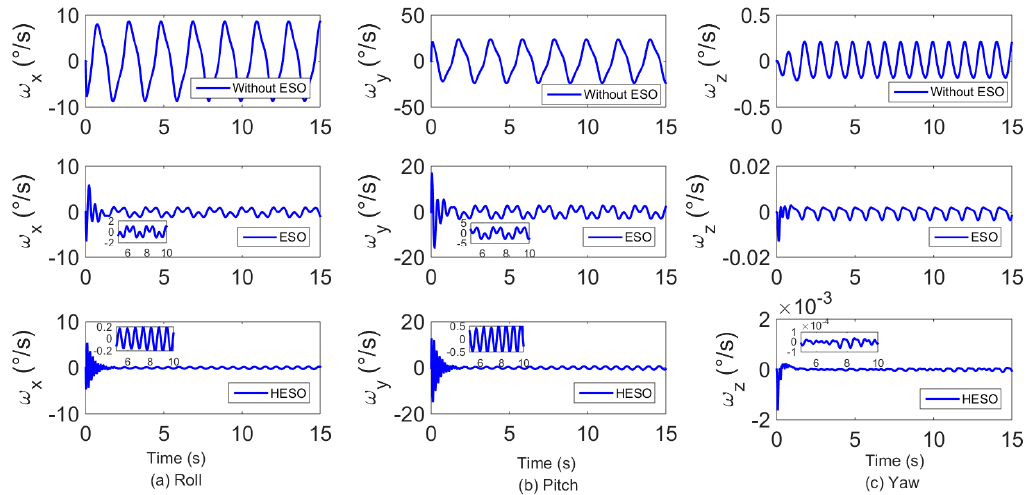
Figure 4. Simulation curves of the attitude rate in attitude stabilization: ( a ) roll channel; ( b ) pitch channel; ( c ) yaw channel.